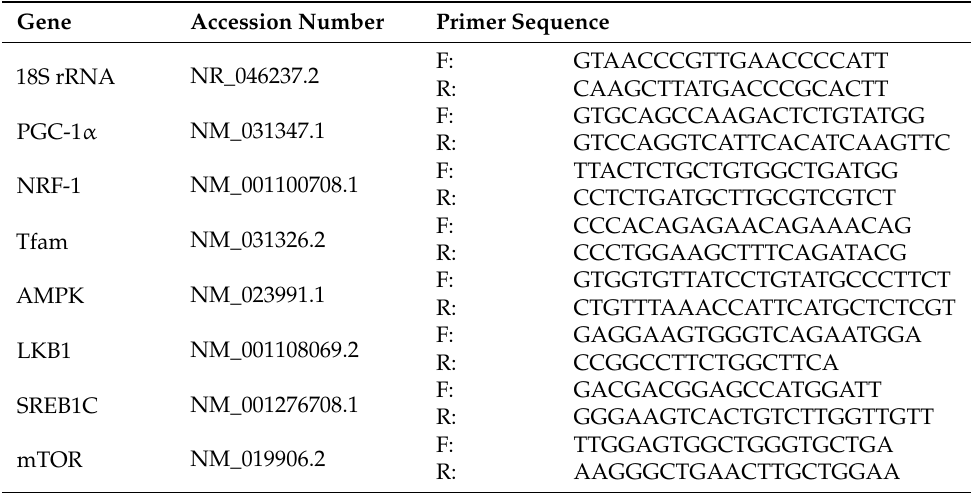
Table 5. Primers were used for the PCR